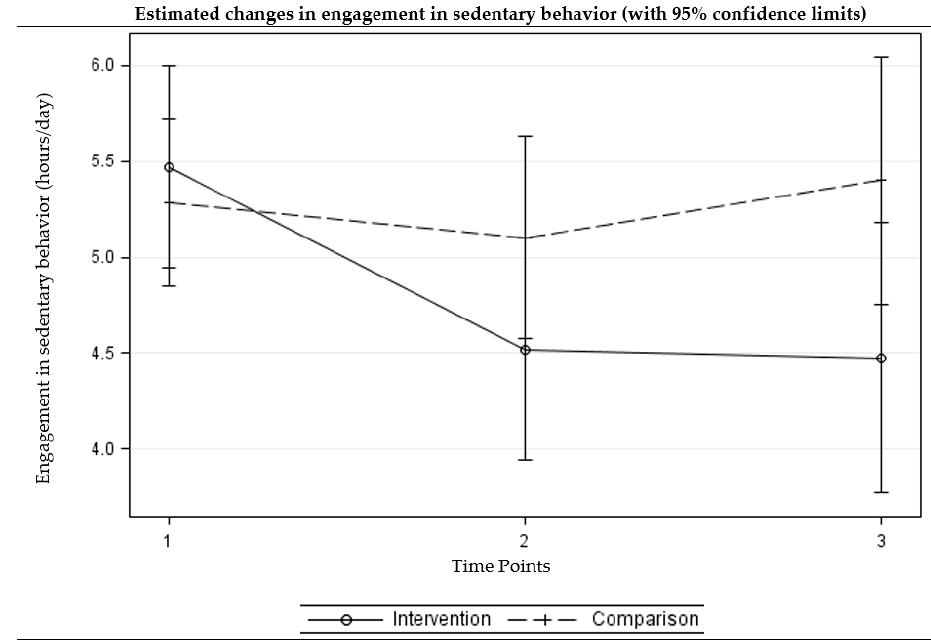
Figure 2. Estimated changes over time in engagement in sedentary behaviors among intervention and comparison groups. (Time points: 1 = baseline, 2 = three ‐ month follow ‐ up, and 3 =six ‐ month follow ‐ up) (Multi ‐ level multivariable mixed ‐ effects linear model).